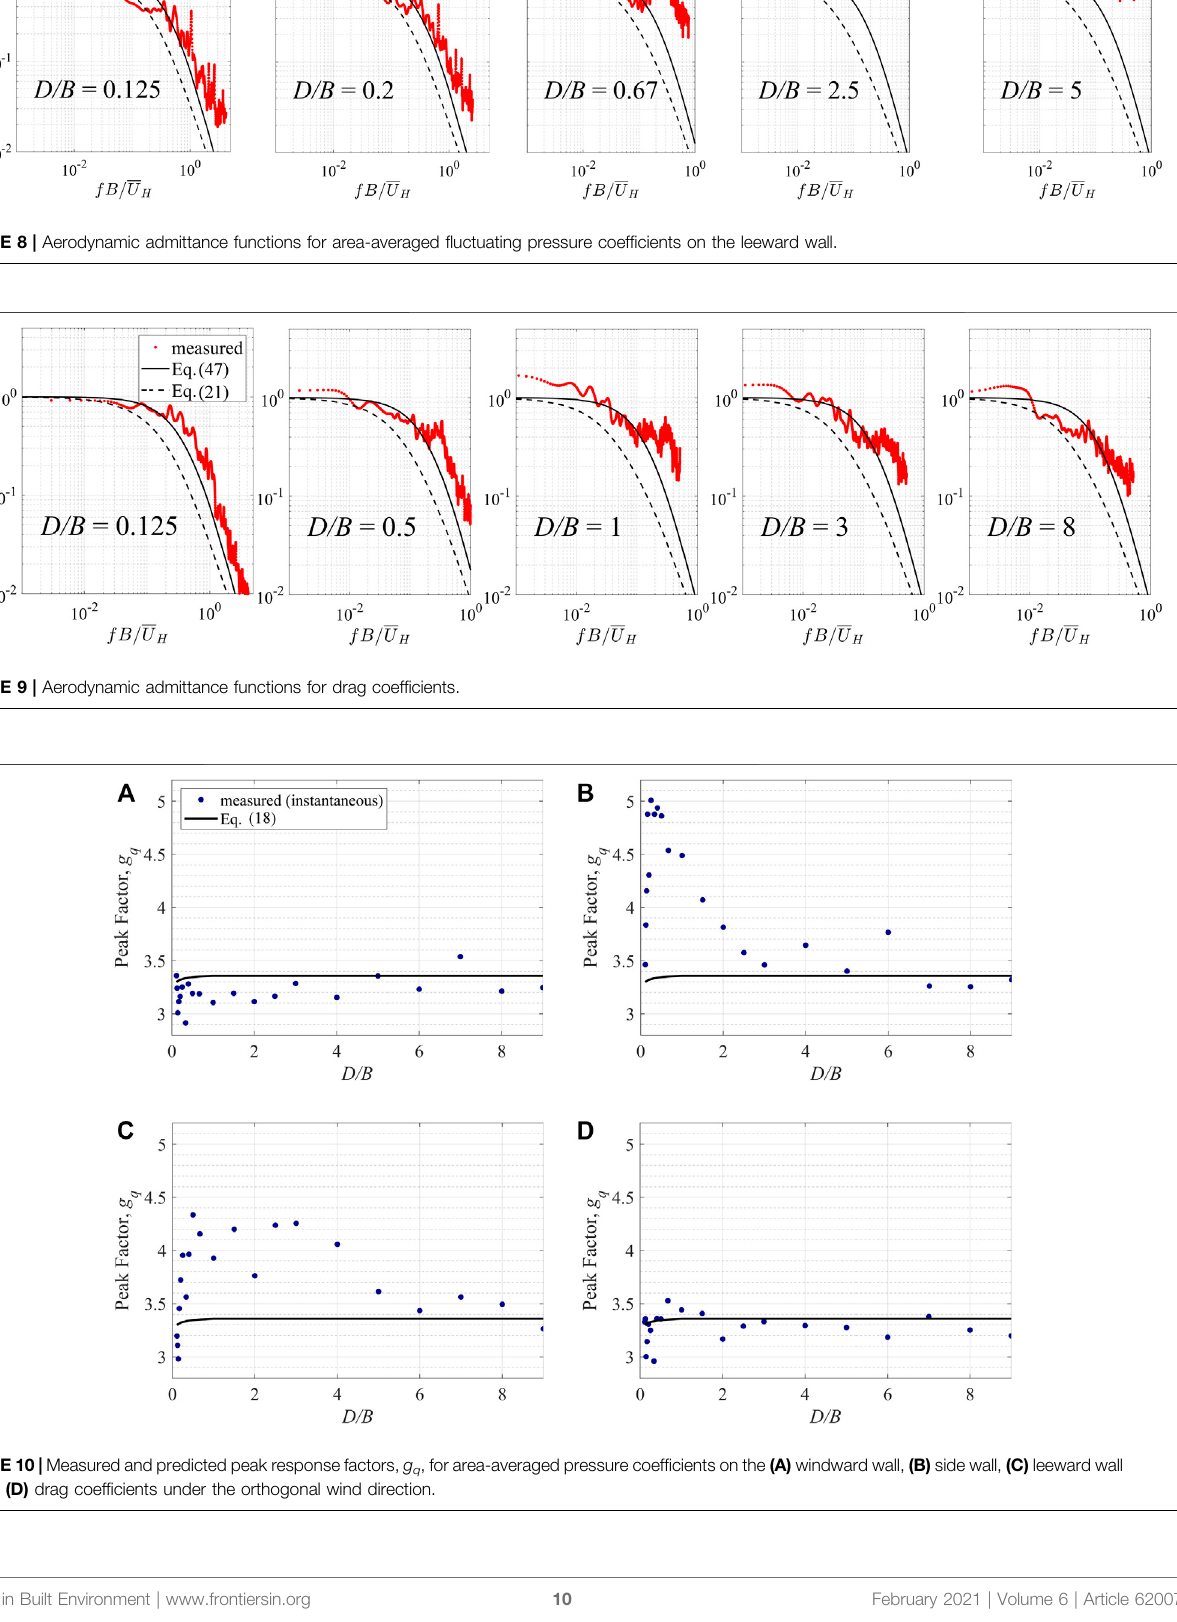
Frontiers in Built Environment |